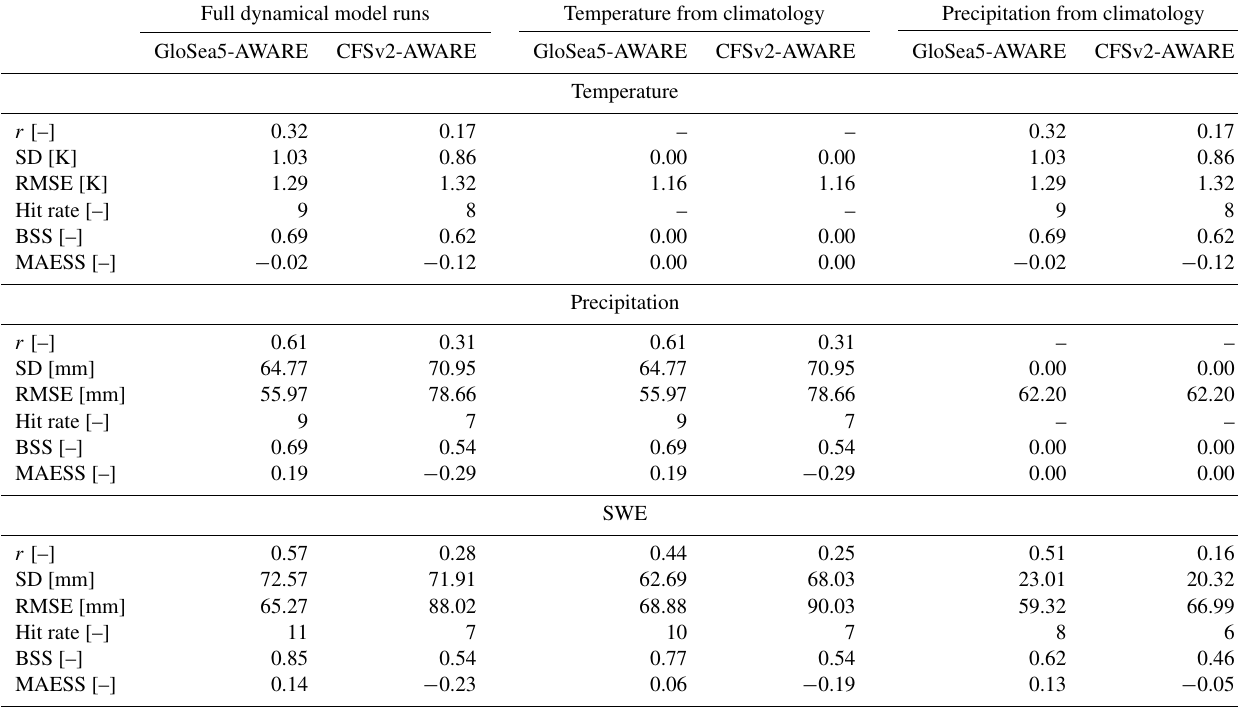
Table 1. Skill measures for basin-scale averages of NDJF temperature, NDJF precipitation, and SWE in February. For each experiment, results for GloSea5-AWARE and CFSv2-AWARE are summarized. The first experiment (full dynamical model runs) refers to the standard setting of CM-based seasonal forecasts using AWARE (Sect. 3.2), while the other two experiments replace CM-based time series with climatology (Sect. 3.3). Skill measures: r , Pearson correlation coefficient; SD, standard deviation of time series; RMSE, root mean square error; hit rate, number of correctly predicted states (out of 13); BSS, Brier skill score; MAESS, mean absolute error skill score. Please note that the units of SD and RMSE are those of the input time series. HISTALP-AWARE is the reference used in the calculations of r , RMSE, hit rate, BSS, and MAESS.